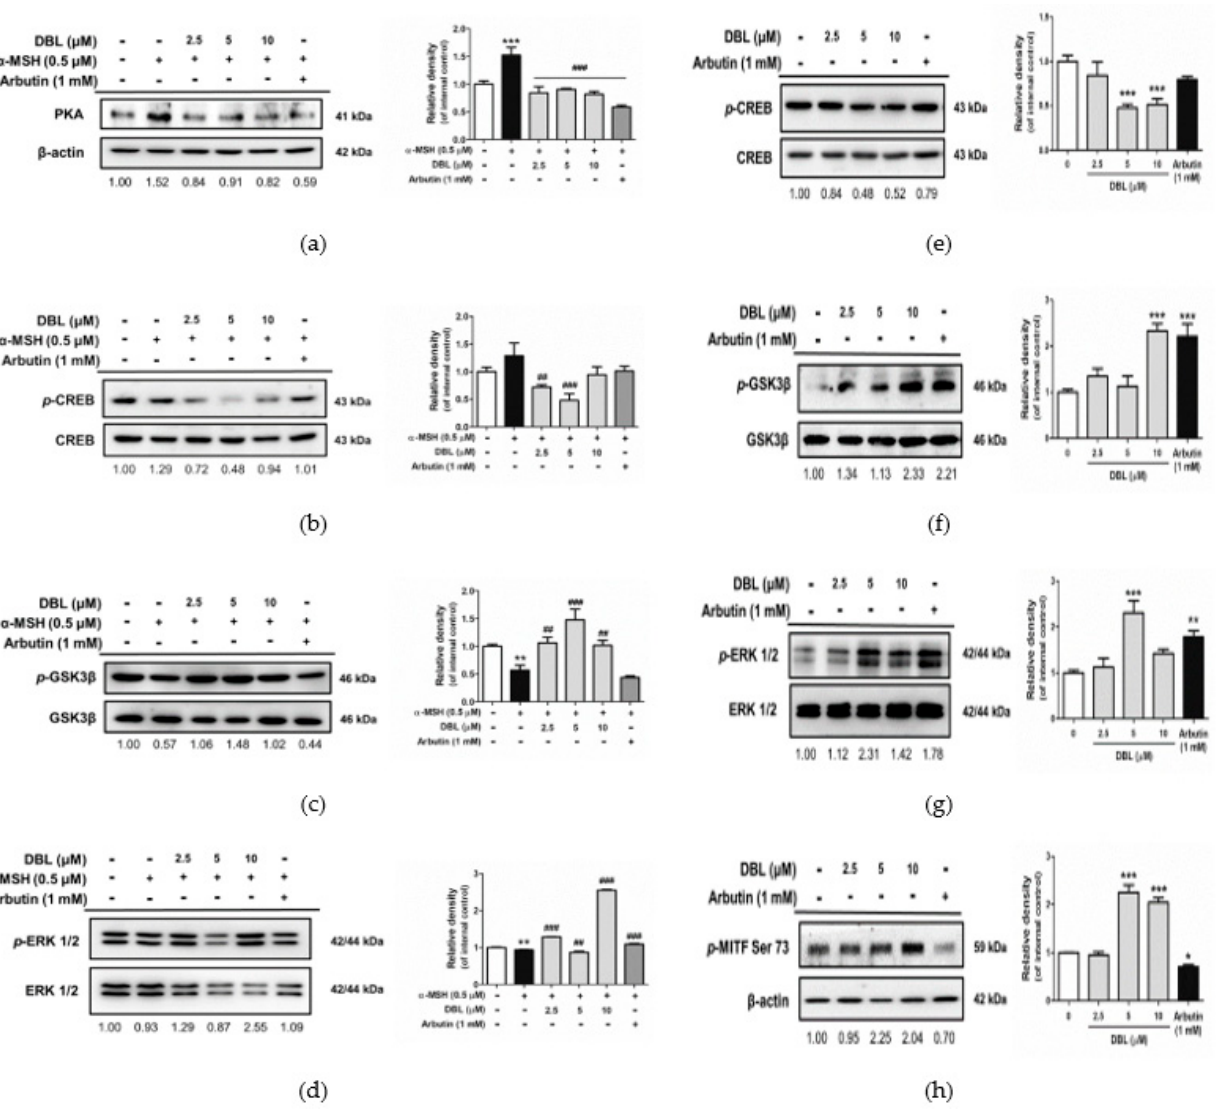
Figure 5. The expression of signaling pathways, in response to the effect of DBL in α -MSH-induced B16F10 and HEMs. Western blot analysis of the expression of ( a ) protein kinase A (PKA), ( b ) p -cAMP response element binding protein (CREB), ( c ) p -glycogen synthase kinase 3 beta (GSK3 β ), and ( d ) p -extracellular regulated protein kinase (ERK) in B16F10 treated with DBL and induced with α -MSH for 48 h. Western blot analysis of the expression of ( e ) p -CREB, ( f ) p -GSK3 β , ( g ) p -ERK, and ( h ) p -MITF serine 73 in HEMs treated with DBL for 72 h. Inserted values indicated relative protein expression in comparison with the internal control ( β -actin, CREB, GSK3 β , and ERK 1/2). All data have been presented as mean ± SD. Significant difference versus control group: * p < 0.05, ** p < 0.01, *** p < 0.001. Significant difference versus α -MSH-treated group: ## p < 0.01, ### p < 0.001. Positive control: 1 mM arbutin.